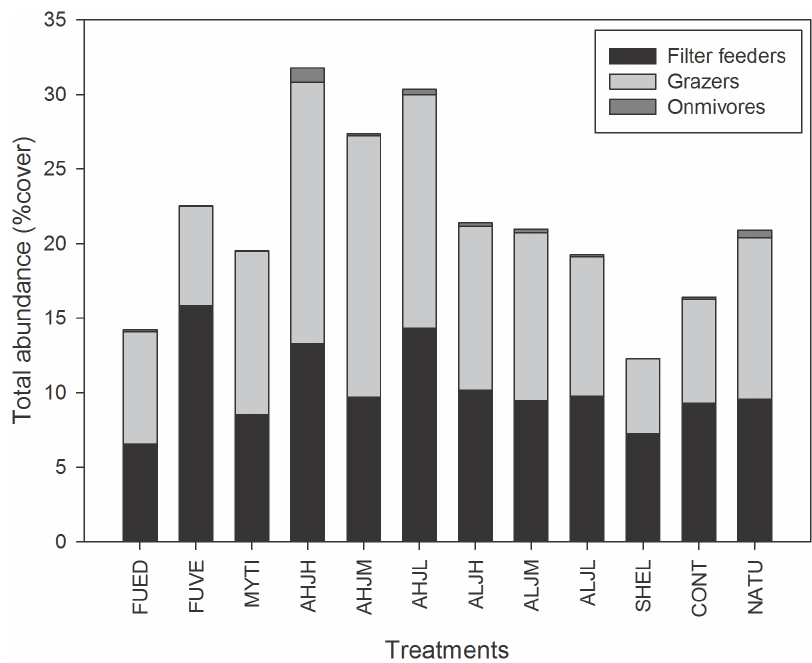
Figure 2. Distribution of total abundance in percentage cover of three trophic guilds among treatments: Grazers (8 species), Filter feeder (5 species) and Omnivores (11 species). See Table 1 for the details of the treatments and Table S1 for details of the trophic guilds group composition.